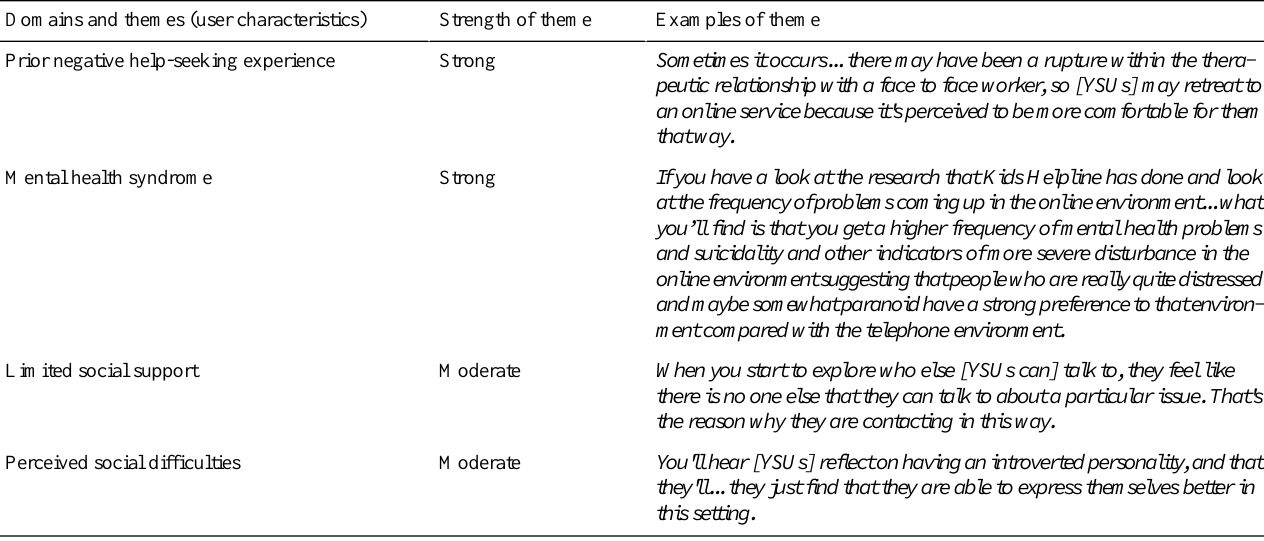
Table 1. Overview of themes identified by text-based online counseling providers about perceived user characteristic domains.